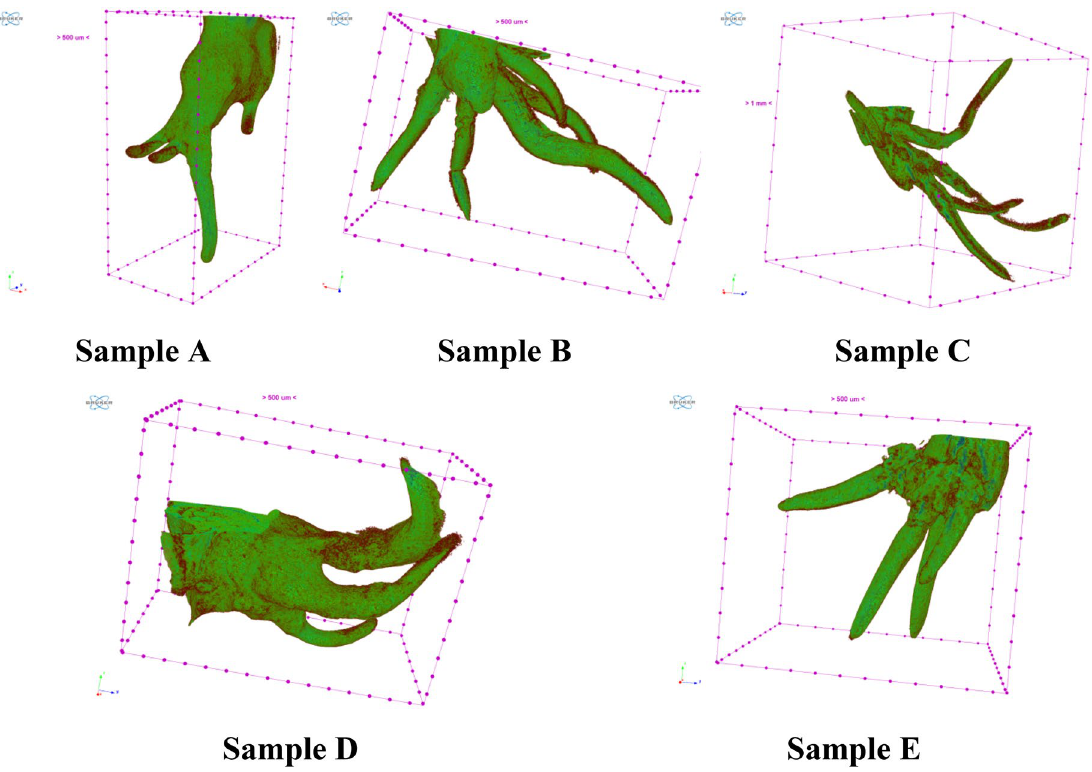
Figure 12. 3D visualization of roots of seed samples by